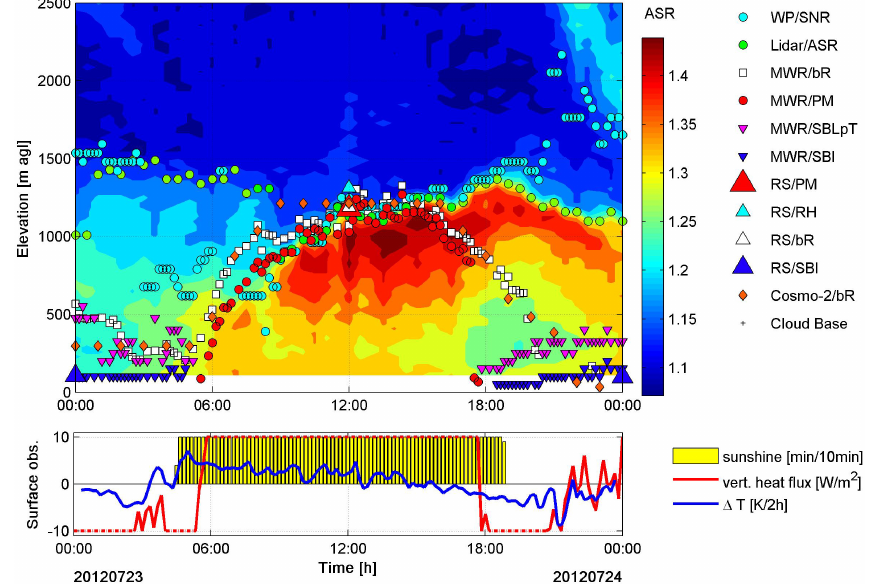
Figure 4. Upper panel: automatic detection of PBL height from all remote sensing instruments, RS and COSMO-2 model for a convective day in summer 2012 at PAY; the background signal corresponds to the lidar/ASR. Lower panel: sunshine duration, vertical heat flux and temporal gradient of surface T . Vertical heat flux greater than 10 or lower than − 10Wm − 2 are limited to ± 10 with a dashed